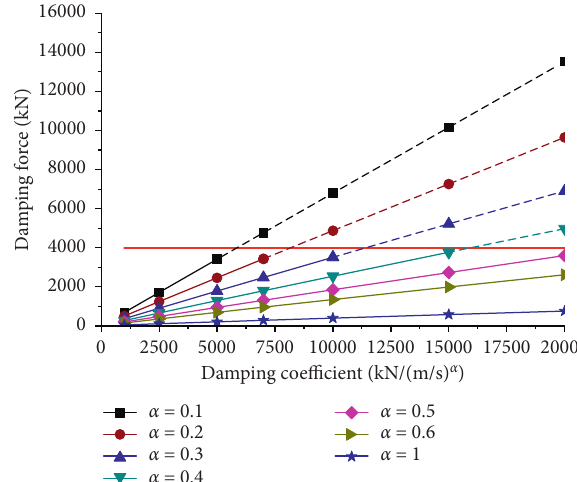
Figure 24: Maximum value of damping force F .